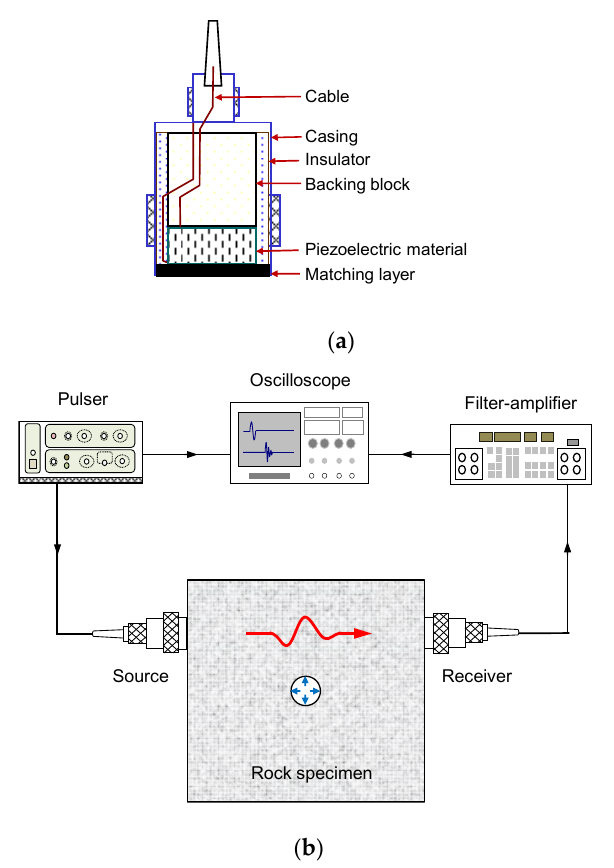
Figure 7. Schematic drawing of the wave measurement system: ( a ) piezoelectric transducer; ( b ) electronic devices with the rock specimen.